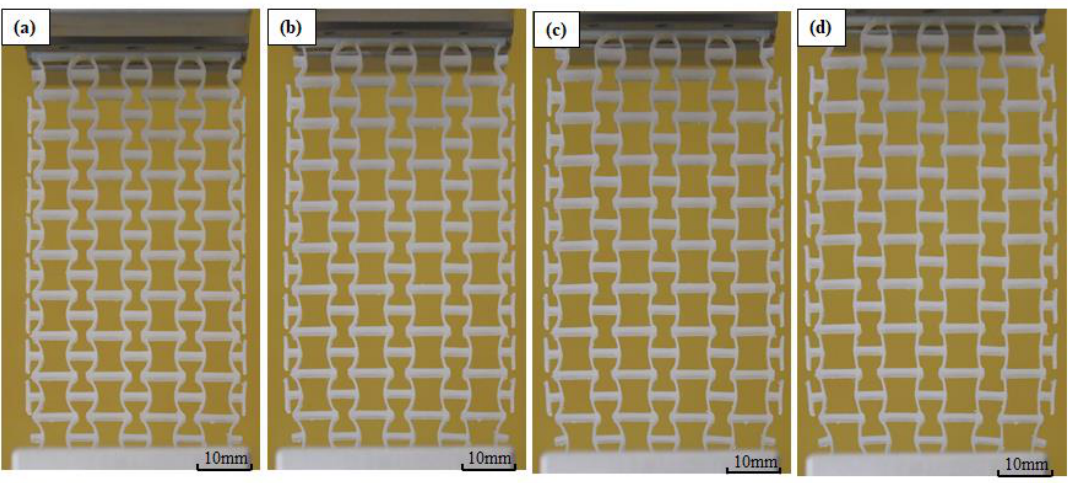
Figure 7. Deformed specimen under tensile loadings: ( a ) initial state, ( b ) strain 0.03, ( c ) strain 0.06 and ( d ) strain 0.09.